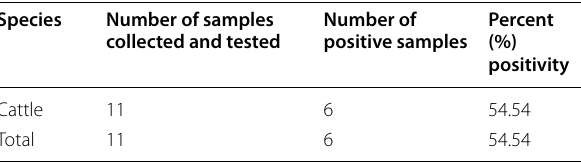
Table 10 Seroprevalence of anti-BTV antibodies among Mizoram animals Species Number of samples collected and tested